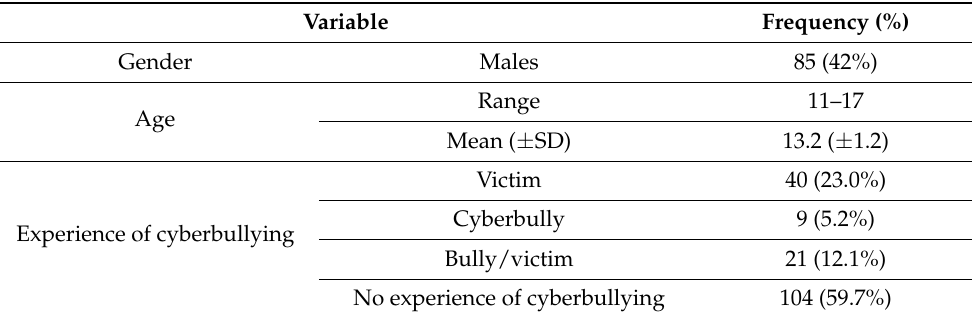
Table 1. Descriptive